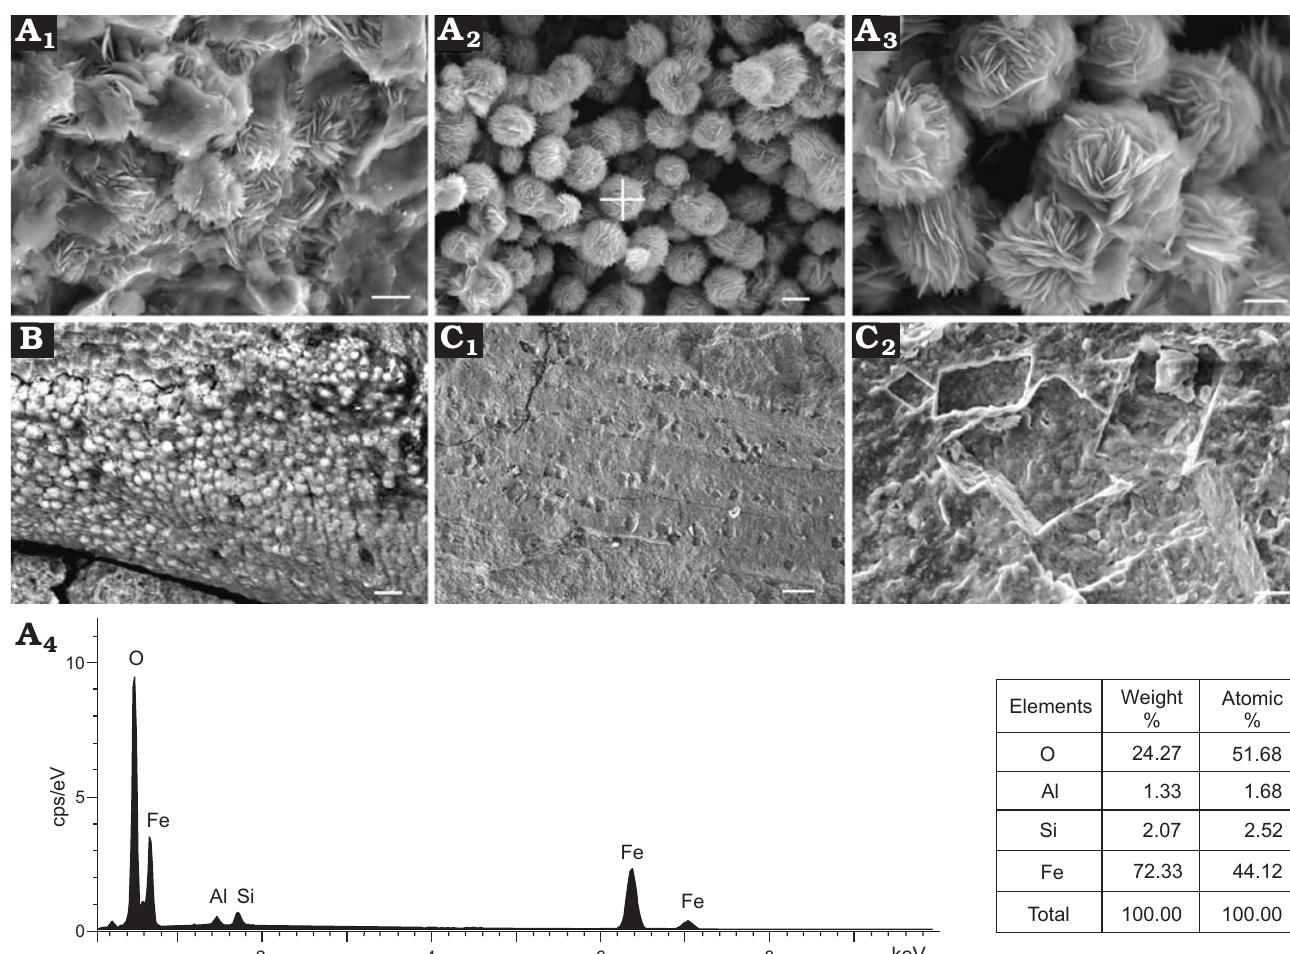
Fig. 2. Scanning electron micrographs of shell and shale fabrics as well as mineral elemental analyses of matrix from the Manto Formation (Cambrian Stage 4/5) in the Zuojiawu section of Tangshan, China. A . NIGPAS 166334, fine grained clay minerals and hematite crystals in the matrix (A 1 ). Tabular crystals of hematite forming rosette-shaped aggregations in the matrix (A 2 , A 3 ); the cross in A 2 shows the location of elemental analysis (A 4 ). B . NIGPAS 166339a, skeleton coated with hematite. C . NIGPAS 166337, halite pseudomorphs distributed on the surface of undetermined fossil (C 1 ), calcite imprints in the matrix (C 2 ). Scale bars: A 1 , A 2 , C 2 , 2 μ m; A 3 , 1 μ m; B, 10 μ m; C 1 , 50 μ